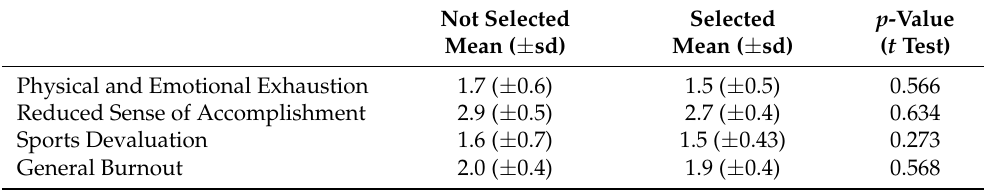
Table 4. Distribution of the mean scores obtained by the athletes selected and not selected for the Brazilian handball team, according to the ABQ dimensions and general burnout. Not Selected Selected p -Value Mean ( ± sd) Mean ( ± sd) ( t Test) Physical and Emotional Exhaustion 1.7 ( ± 0.6) 1.5 ( ± 0.5) 0.566 Reduced Sense of Accomplishment 2.9 ( ± 0.5) 2.7 ( ± 0.4) 0.634 Sports Devaluation 1.6 ( ± 0.7) 1.5 ( ± 0.43) 0.273 General Burnout 2.0 ( ± 0.4) 1.9 ( ± 0.4)